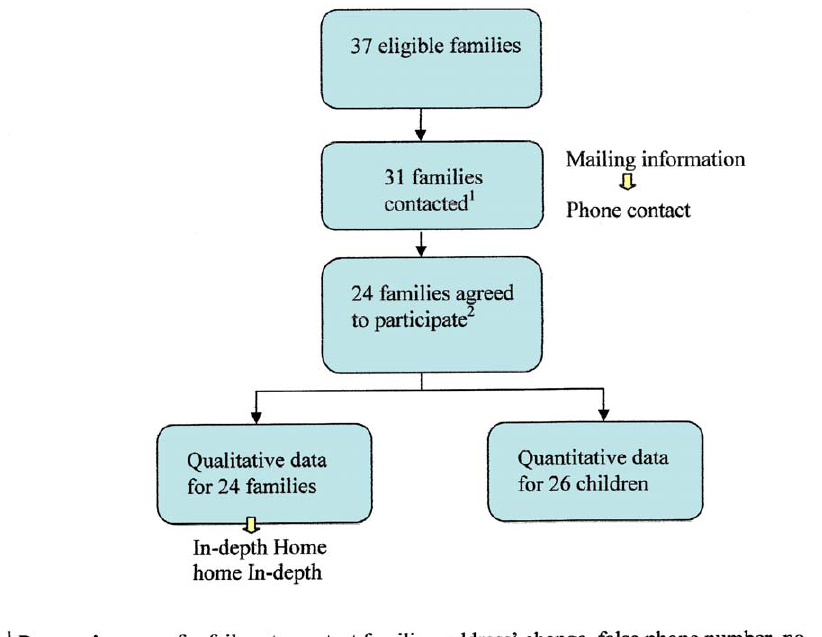
Figure 1. Set up of the study. Thirty-seven families who adopted in 2003 in the department of Puy de Dome, France were eligible for the study.